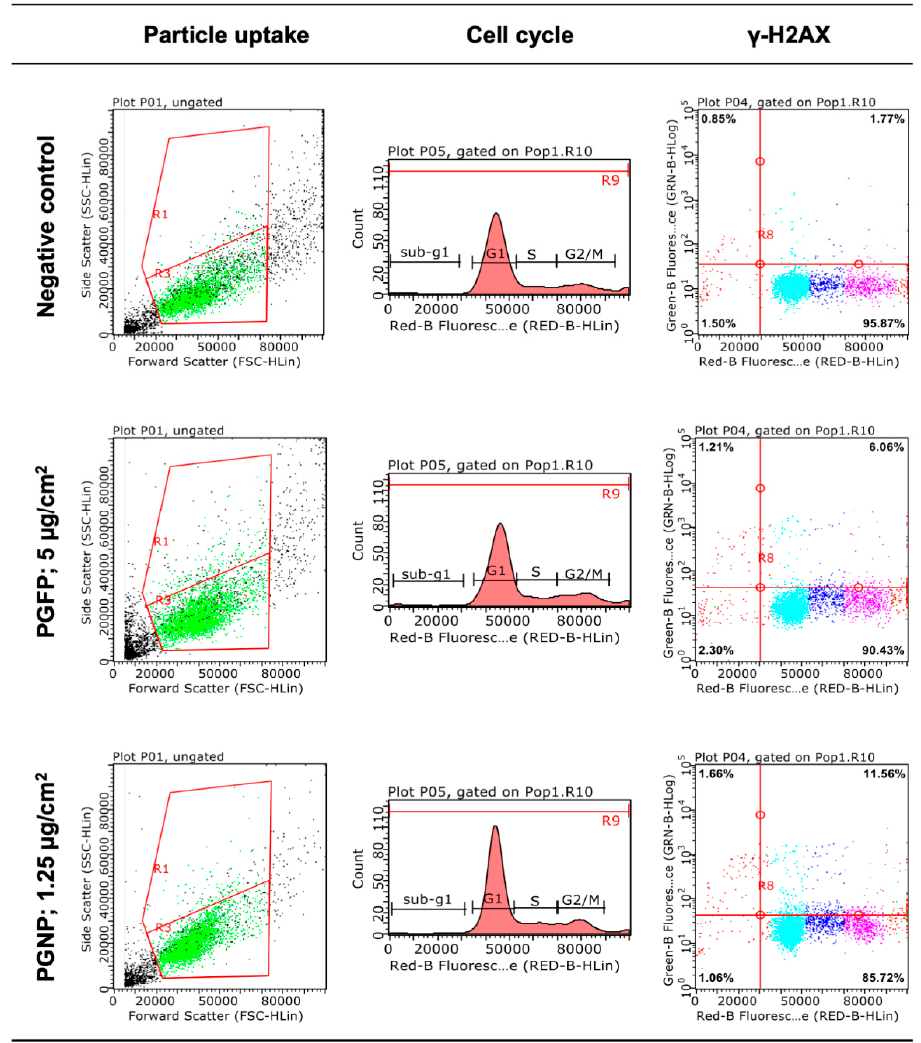
Figure A1. Representative flow cytometry graphs obtained for particle uptake, cell cycle and γ -H2AX analysis in human alveolar epithelial cells incubated for 24 h with the highest tested concentration of process-generated fine (PGFP) and nano-sized (PGNP) particles released during high-velocity oxy-fuel spraying (HVOF).